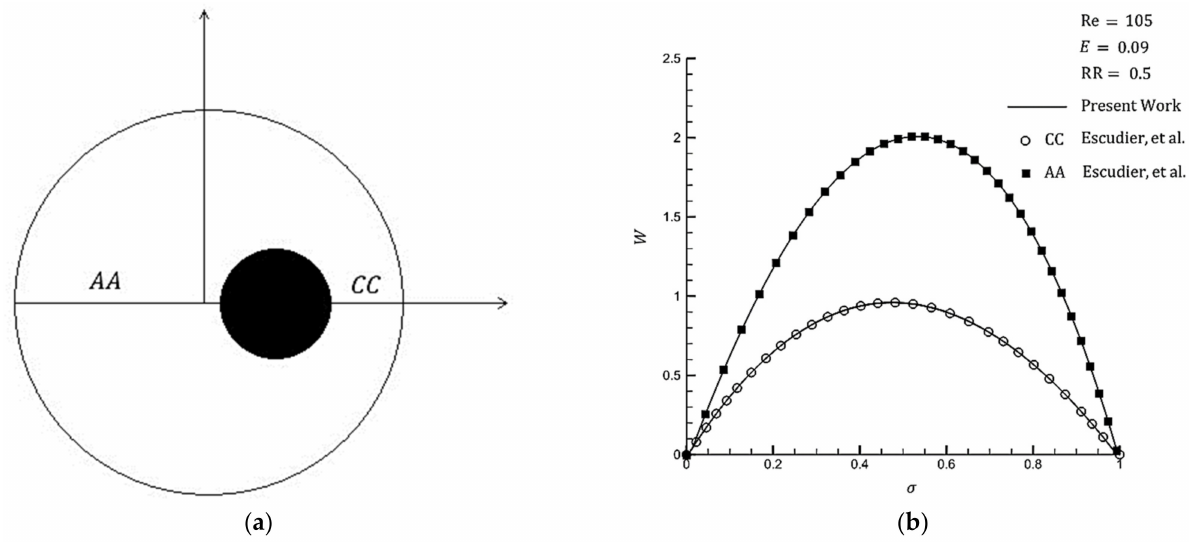
Figure 10. ( a ) Schematic geometry with specified cross-section, and ( b ) comparison of axial velocity profile with results of Escudier et al. [33] at two different slices (AA and CC).